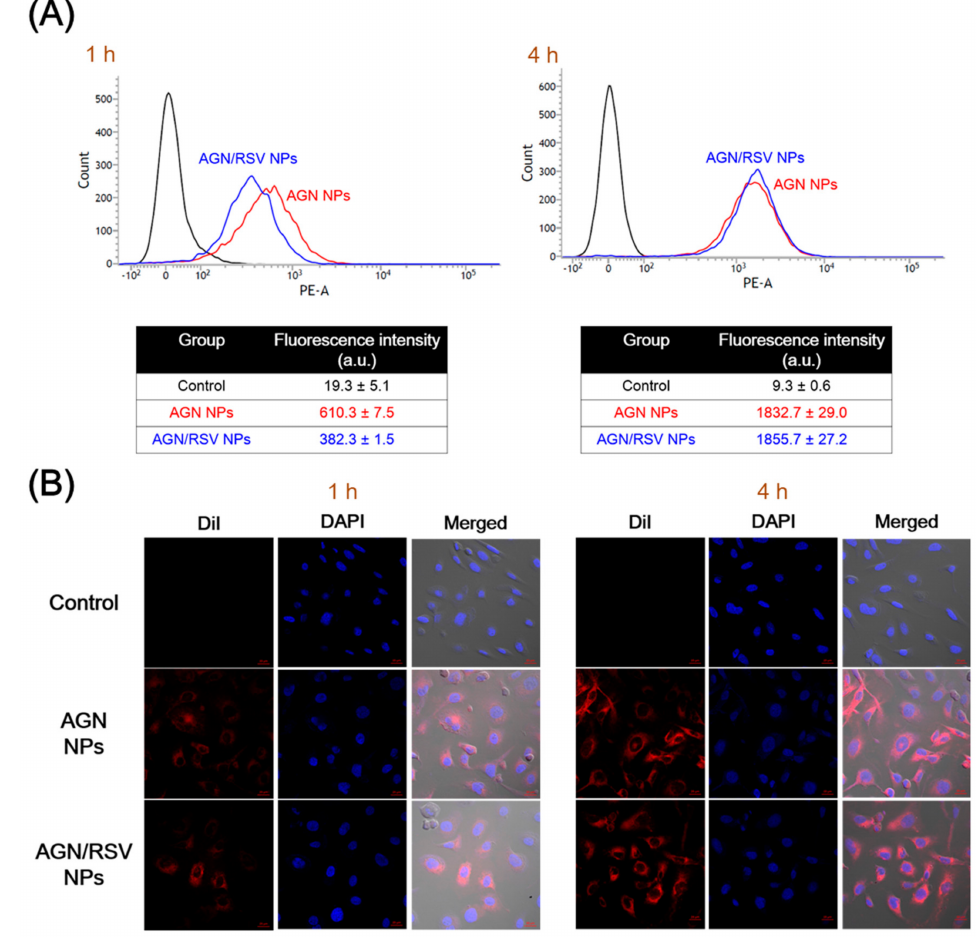
Figure 5. The cellular internalization and localization of DiI-loaded AGN NPs and AGN/RSV NPs in SKOV-3 cells. ( A ) The cellular internalization efficiencies of DiI-loaded NPs measured by flow cytometry. The mean fluorescence intensity values after 1 h and 4 h of incubation are presented. The data are shown as the mean ± SD ( n = 3); ( B ) The intracellular localization of DiI-loaded NPs observed by CLSM imaging. DiI (red color), DAPI (blue color), and merged images of control, AGN NPs, and AGN/RSV NPs after 1 h and 4 h of incubation are shown. The length of scale bar (red color) is 20 µ